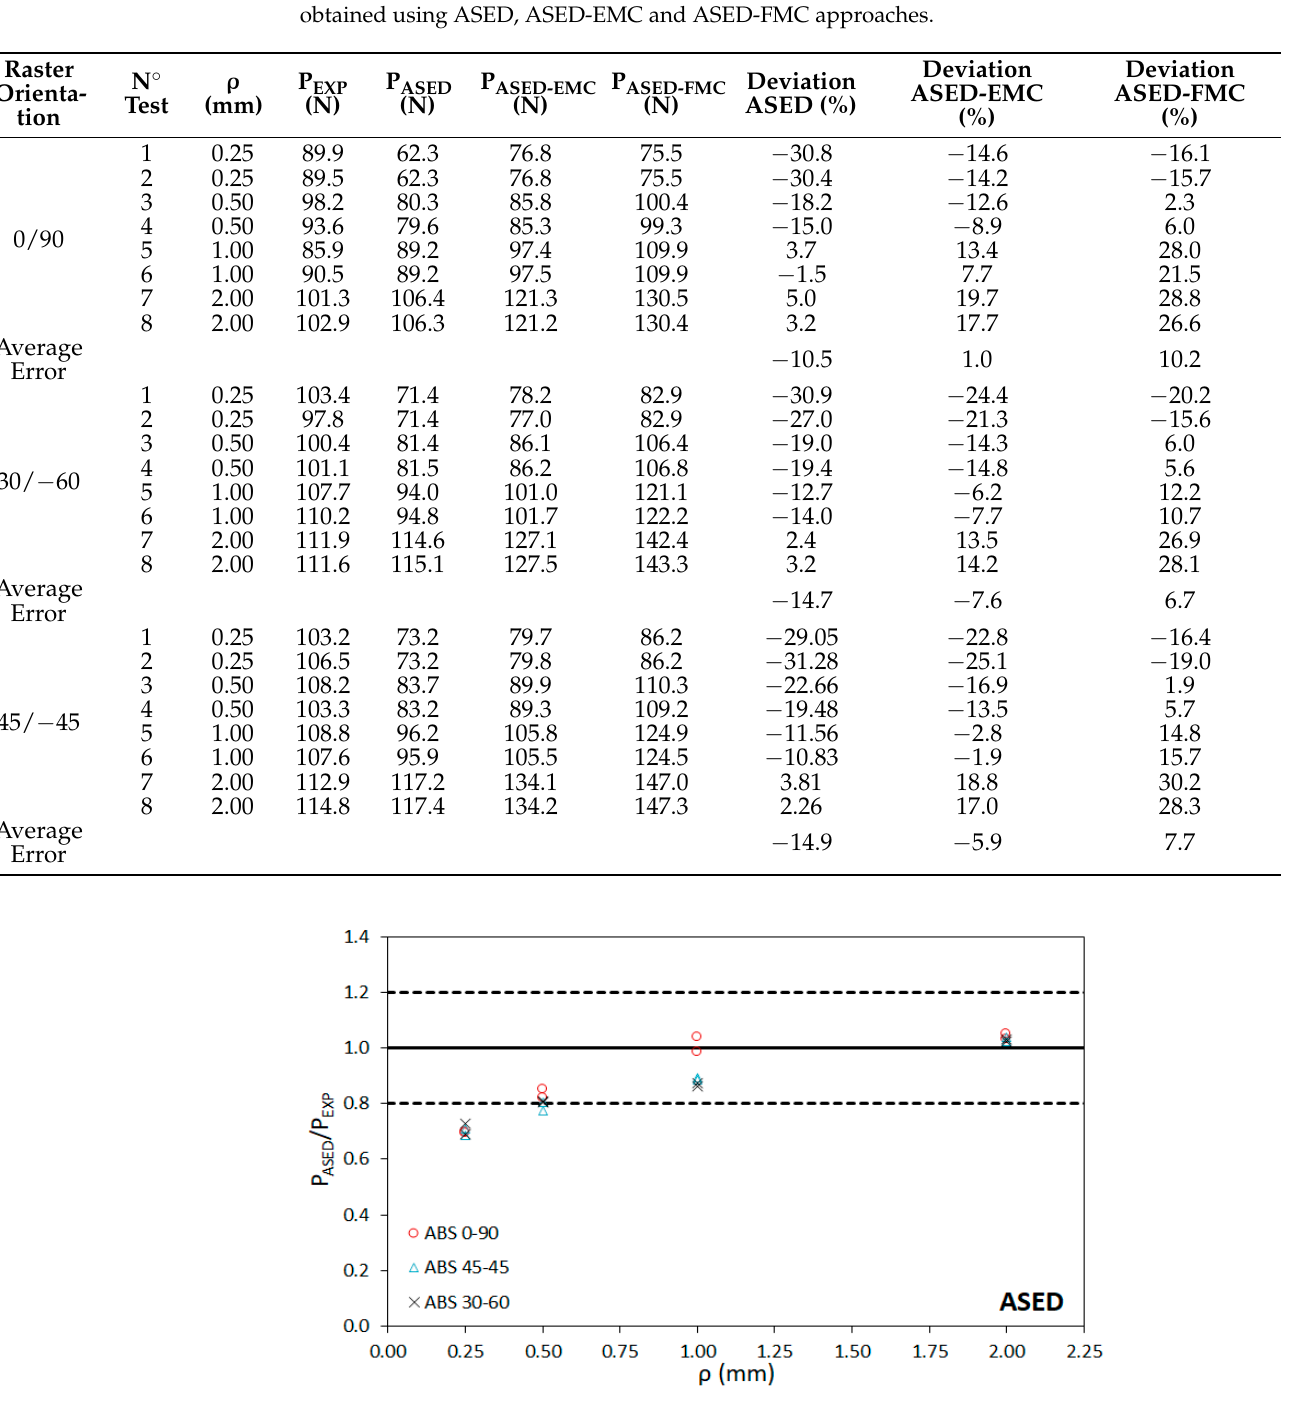
Figure 8. Comparison between fracture load predictions using ASED-EMC and experimental frac- ture loads. Figure 9. Comparison between fracture load predictions using ASED-FMC and experimental frac- ture loads.